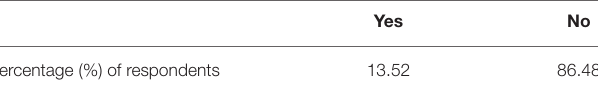
TABLE 13 | Responses to the question “Have you heard of the International Whaling Commission